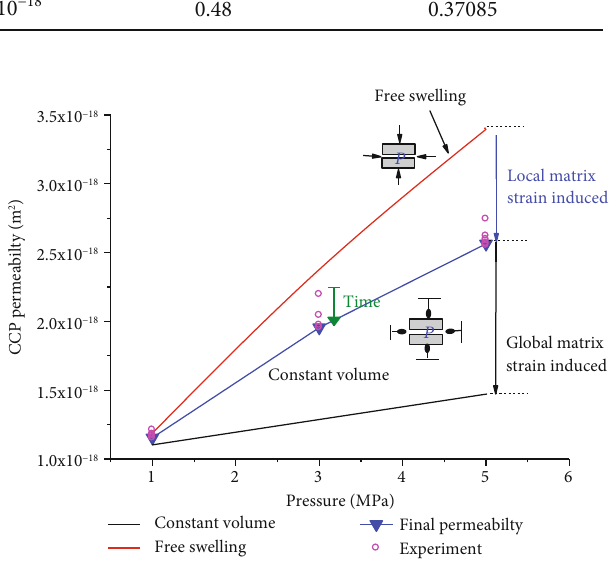
Figure 16: Comparison between the observed coal permeability change in the lab and the theoretical solution, both of which are bounded by free swelling and constant volumetric models (the con fi ning pressure of the coal sample is held).